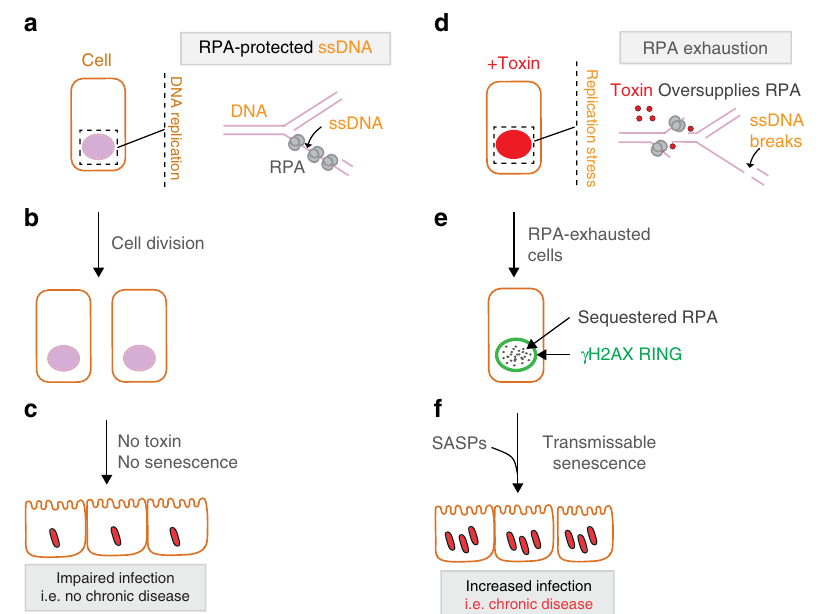
Fig. 6 Proposed Model. Left: a Control cells undergo DNA replication where RPA protects ssDNA from breakage. b Cells divide, and c no senescence is observed, which impairs Salmonella infection. Right: d The typhoid toxin causes an initial burst of DNA damage in G1 that combines with damage in S-phase to cause replication stress by oversupply of the RPA substrate ssDNA. e RPA sequestration causes DNA damage that manifests as γ H2AX RINGs. f RING cells enter into a senescence-like state resulting in SASP-induced transmissible senescence that promotes Salmonella invasion into host cells. Thus, toxin manipulation of infection niches via senescence may contribute to chronic Salmonella infections, which are associated with the typhoid toxin EcCDT-1 into pETDuet-1 as typhoid toxin. Recombinant His-tagged toxins were expressed overnight in E.coli BL21 DE3 (#69450, Merck Millipore) at 30 °C fol-